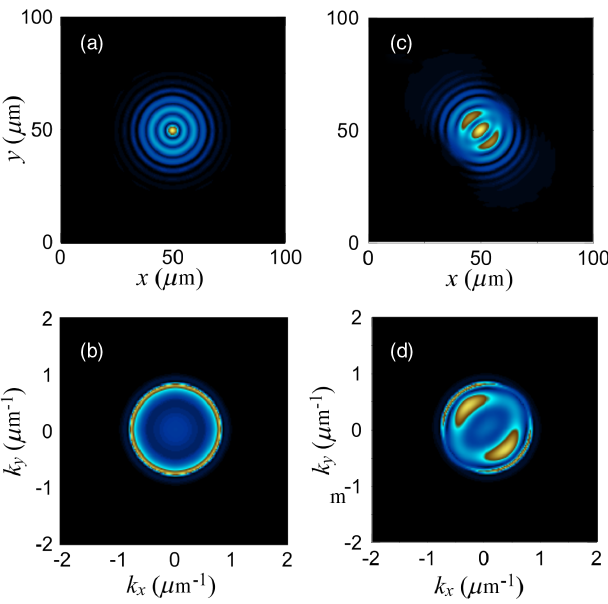
FIG. 7. Calculated polariton density distributions below bist- ability threshold. Intensity profiles of steady-state solutions are shown in real (a),(c) and momentum (b),(d) space. (a),(b) Radially symmetric solution in a low-pump limit for A 2 0 ¼ 0 . 01 . (c),(d) Stable dipole state for A 2 0 ¼ 0 . 0529 . Other parameters are similar to those of Fig.